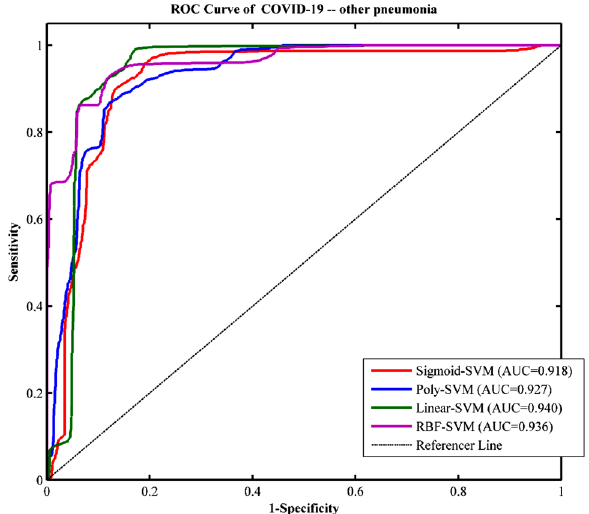
Figure 3. ROC curve of a SVM model based on different kernels for classification of COVID-19 and other pneumonias.